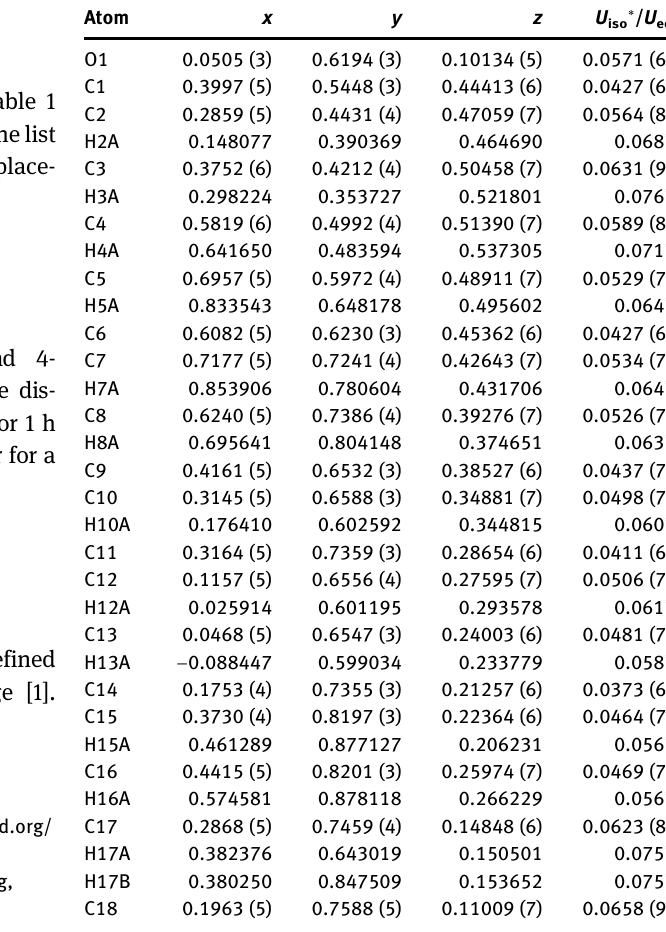
Table  : Fractional atomic coordinates and isotropic or equivalent isotropic displacement parameters (Å 